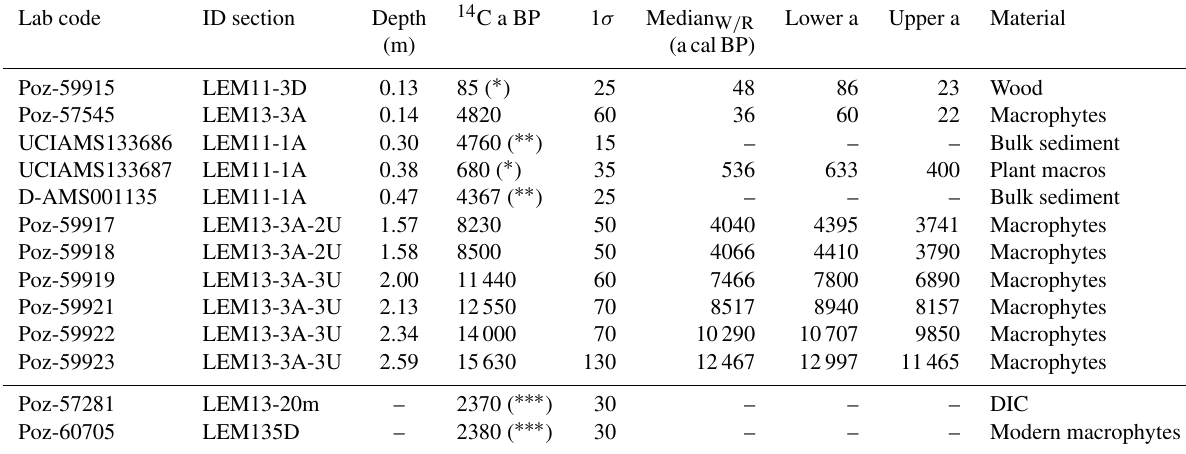
Table 1. Radiocarbon dating of LdM sequence. We used only the macrophyte samples for the construction of age–depth model with a reservoir correction of 4700a. The table shows the median age with reservoir effect corrected from the Bayesian age–depth model and uncertainties (lower and upper error).